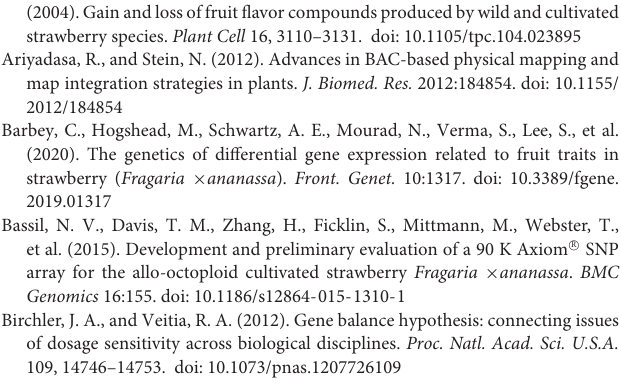
Supplementary Figure 2 | Matrix pool screening of positive clones from each super pools with two gene based markers, qFaFAD1 and UFGDHRM5, and location of positive clone. The number and position of BAC clone is determined by the combination of positive bands in each wells of plate, row, and column. Supplementary Figure 3 | DNA sequence alignment of six BAC clones. Green bars and blue box show the FaFAD1 deletion region. Red bars show the FaFAD1 primer sites of qFaFAD1 and UFGDHRM5. Supplementary Figure 4 | DNA sequence alignments of ‘Camarosa’, ‘Reikou’, and BAC_GD004. The positions of HRM and KASP markers are highlighted with a yellow box and green color, respectively. A blue box indicates the 8,262 bp deletion between γ -D producers and γ -D non-producers. SNPs and InDels were highlighted gray and red colors, respectively. Supplementary Table 1 | Bacterial Artificial Chromosome (BAC) libraries of three strawberry accessions. Supplementary Table 2 | De novo assembly results of six BAC clones. Supplementary Table 3 | Marker sequence information used in this